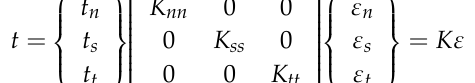
Table 5. Material parameters of composite adhesive interface layer [13].